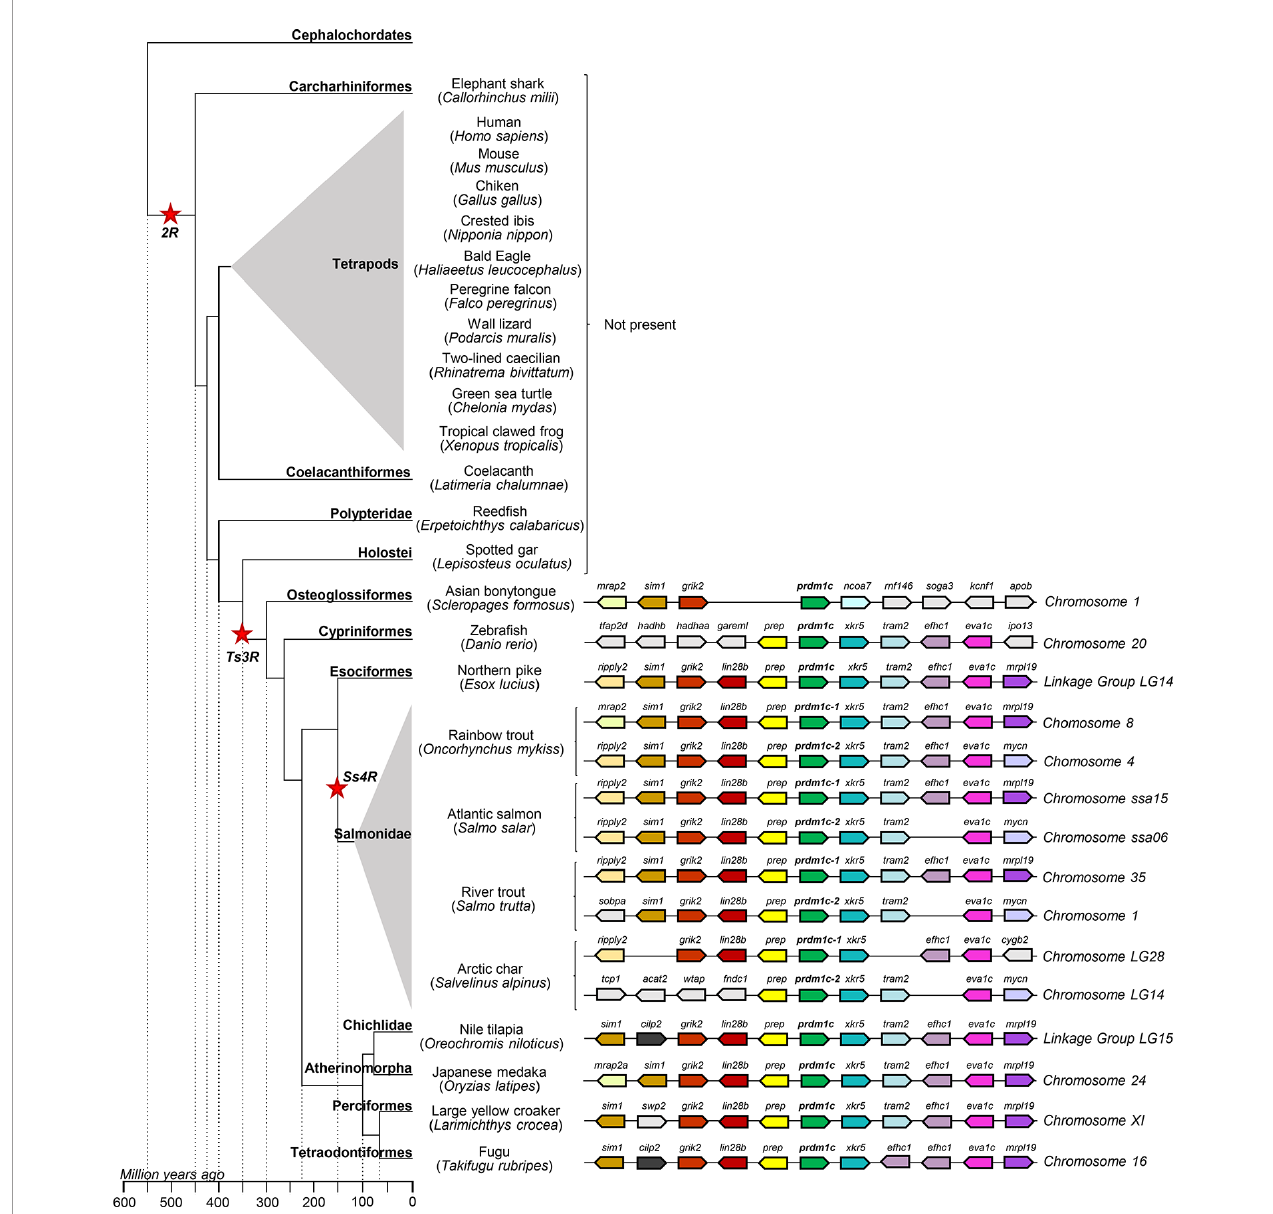
FIGURE 5 | Synteny analysis of the prdm1c group from O. mykiss associated to phylogenetic reconstruction. Different genes are represented by different colored arrows. The prdm1c neighboring genes were identi fi ed along different genomes available in the RefSeq database. Nonconserved genes along the fi gure are shown in gray. Arrows indicate the gene direction relative to prdm1c